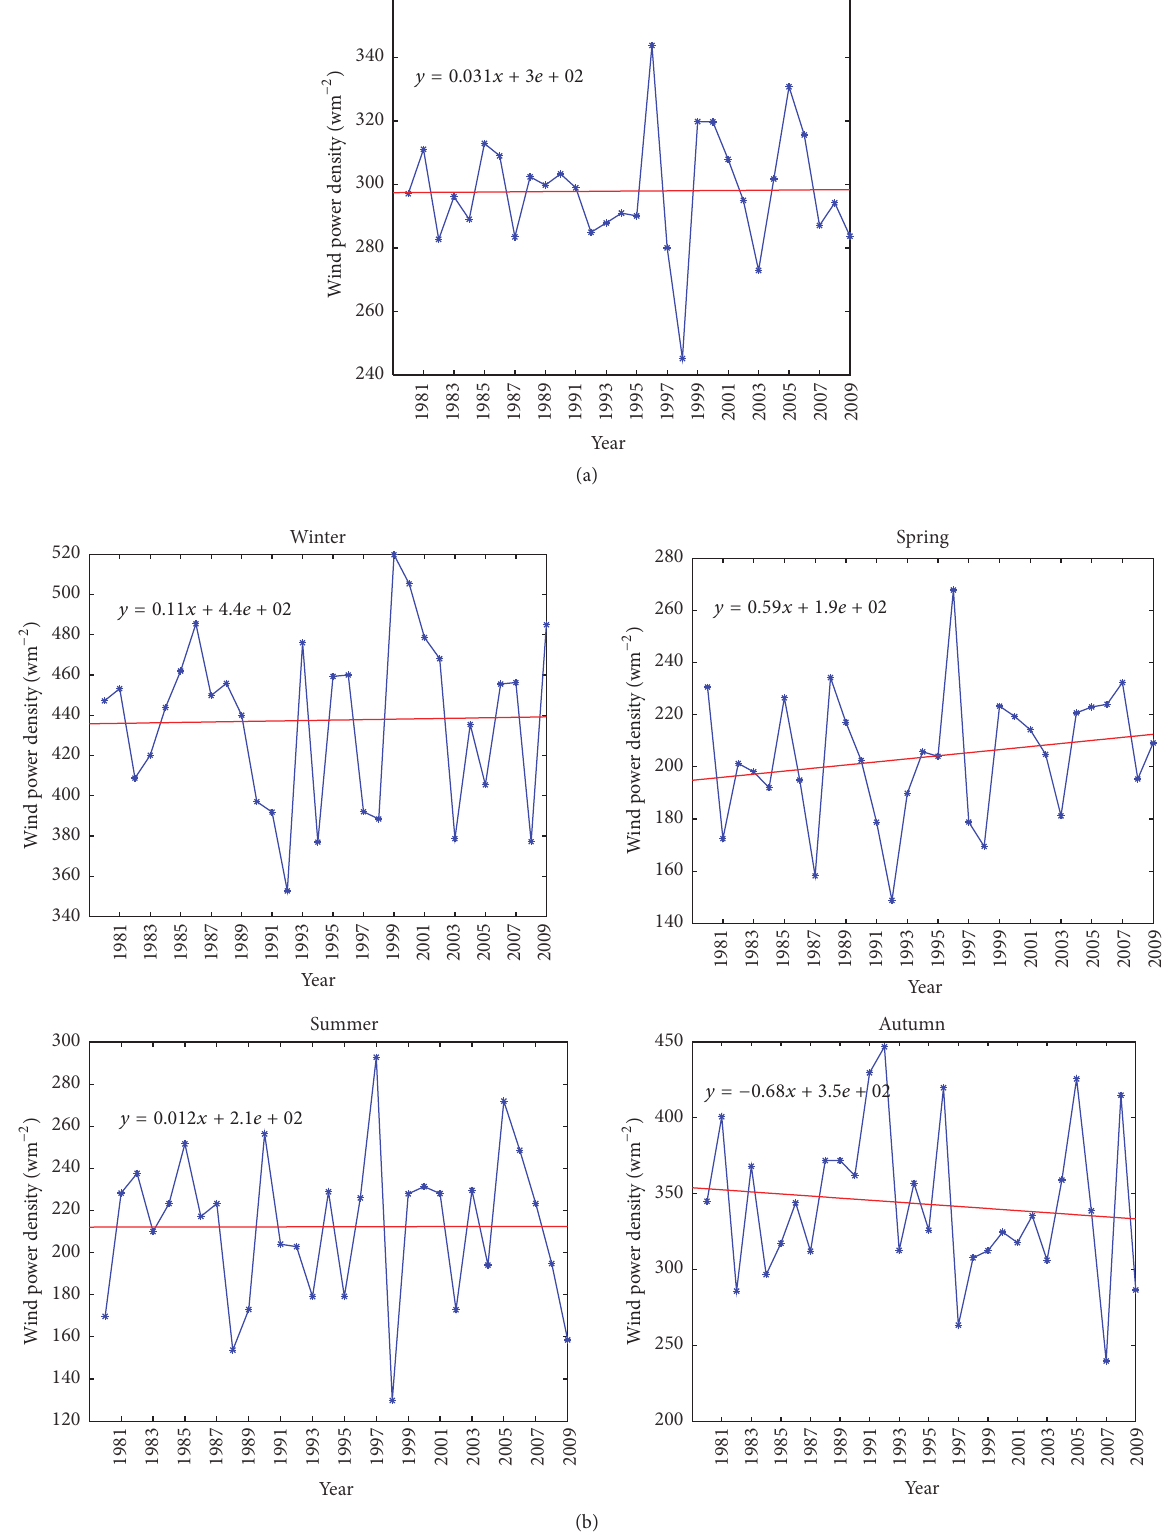
Figure 13: (a) Annual and (b) seasonal temporal trends in wind power density for the period 1980–2009 in the ECS, unit: w/m 2 yr −1